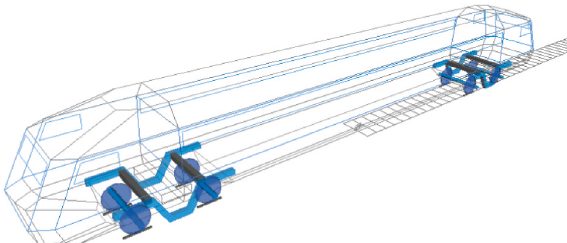
Figure 3: The vehicle dynamic model established on